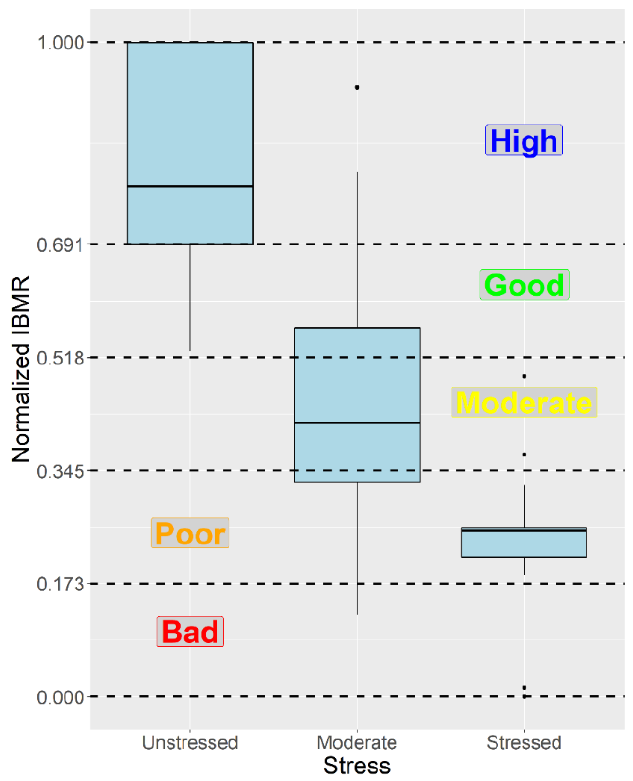
Figure 5. Ecological quality class boundaries of the normalized IBMR GR index.